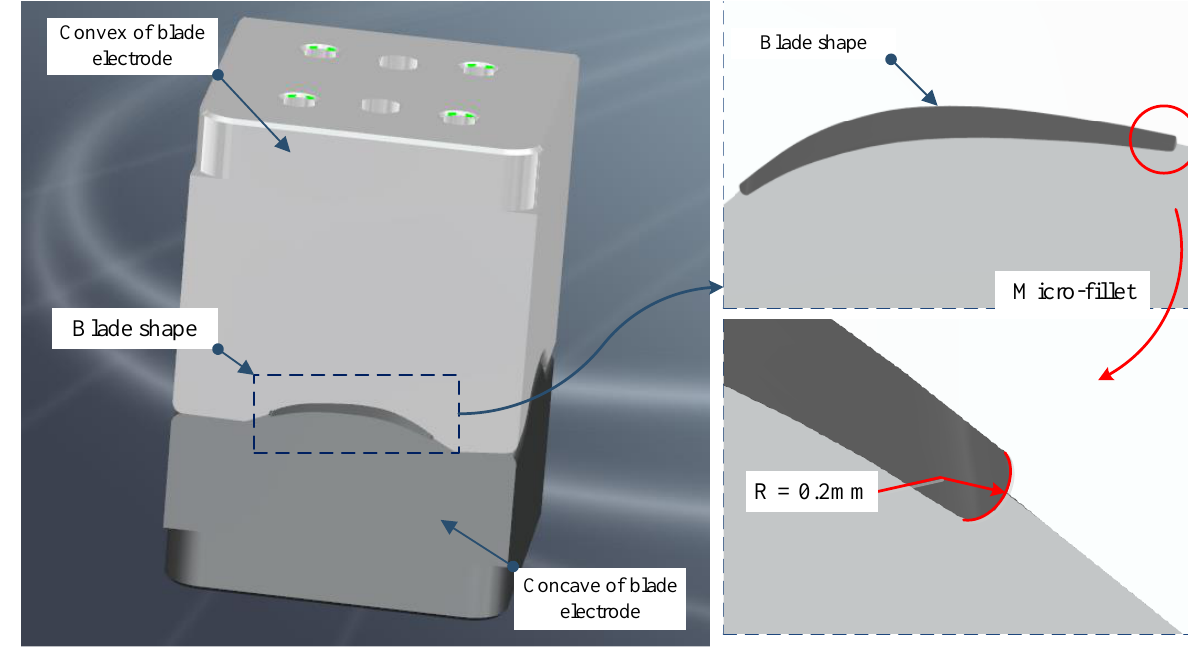
Figure 2. Assembly structure of blade electrode.